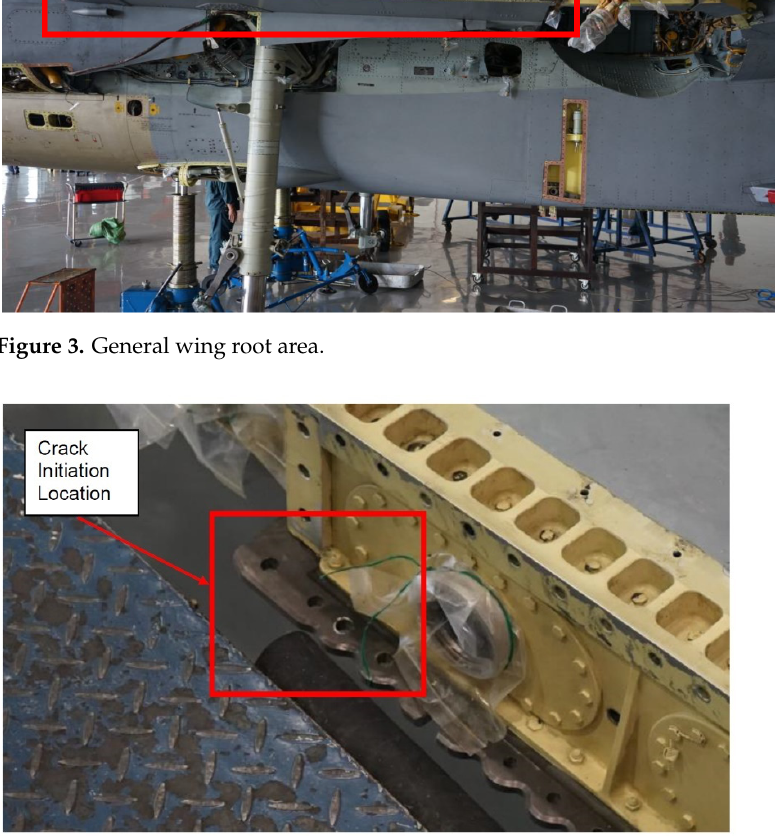
Figure 4. Crack initiation location.